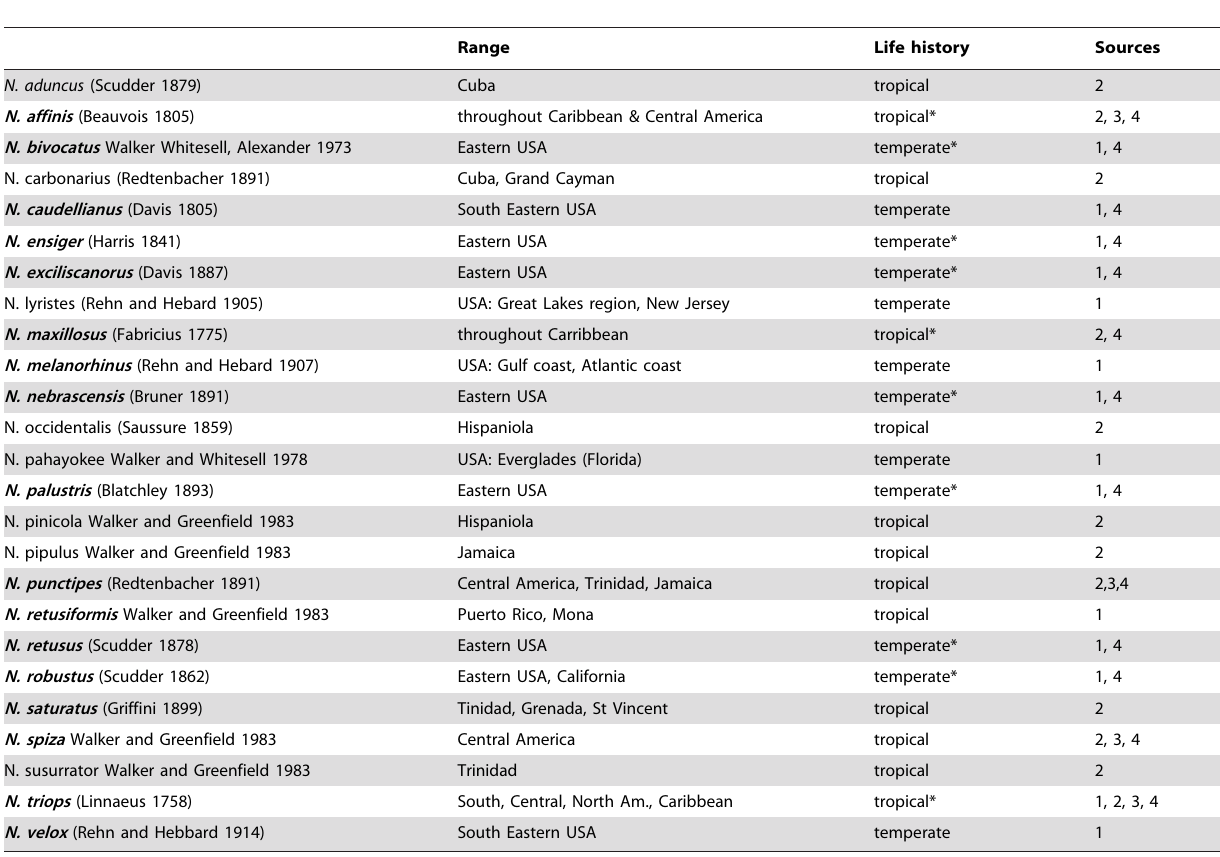
Table 1. The 25 species of Neoconocephalus with ranges in North America, Central America and the